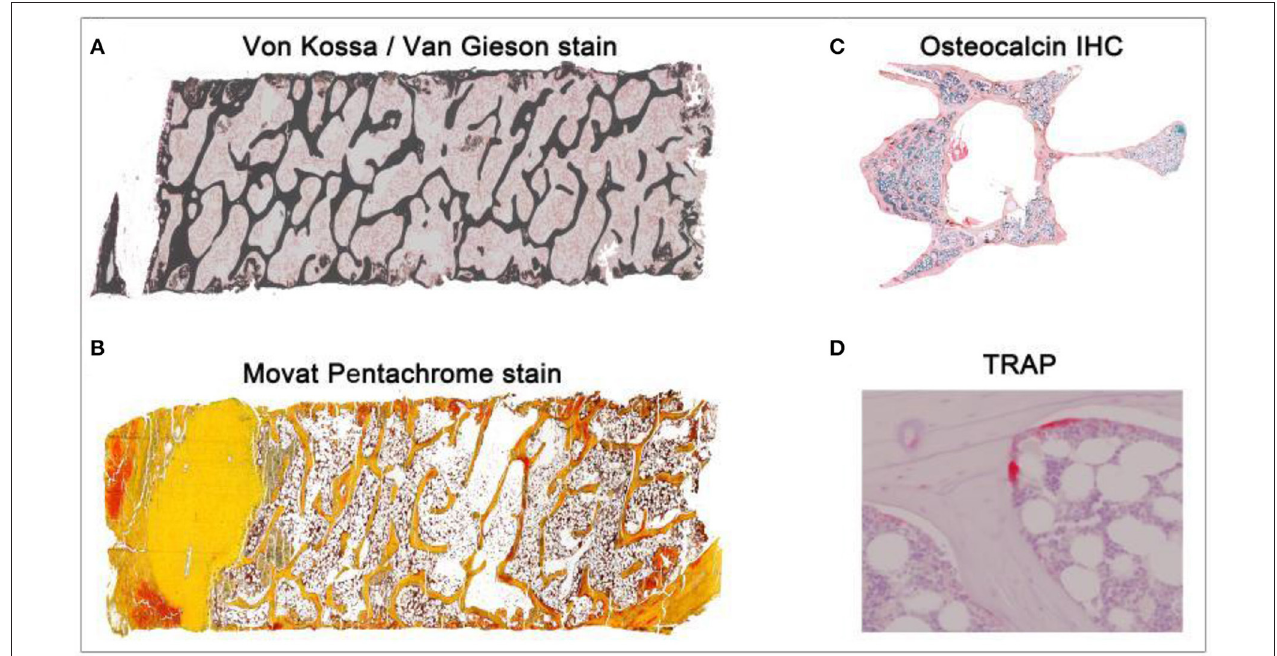
FIGURE 1 | Overview of different histological stains evaluated using TWS and ImageJ toolbox. Sheep iliac crest biopsy and rat lumbar vertebral samples were used to test and set up the protocol. Sheep biopsy samples were embedded in PMMA resin and rat samples were embedded in paraffin. (A) Iliac crest sheep biopsy stained with Von Kossa/Van Gieson helped in visualization of mineralized and non-mineralized bone matrix (5X magnification). (B) Movat pentachrome stain visualized cartilage, osteoid, and ossified tissue distinctly in sheep sample (5X magnification). (C) Osteocalcin IHC visualized the region of osteoblast activity in rat osteoporotic sample (10X magnification). (D) TRAP helped in investigating osteoclast activity in the rat bone (40X magnification).